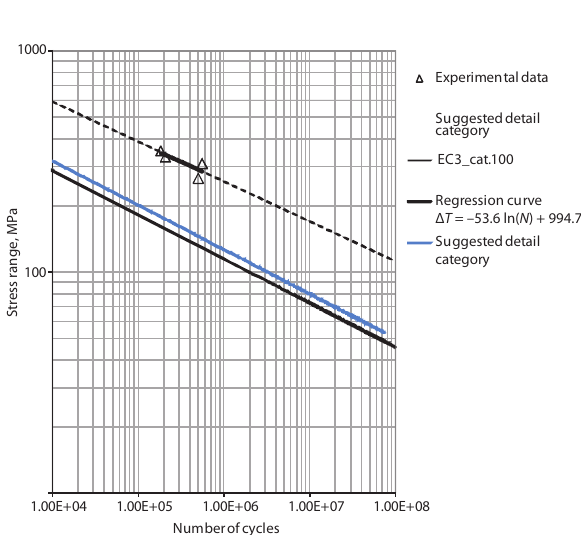
Fig. 4. Test data, best fit, suggested category C = 110 and fatigue design curve category 100 according EN 1993-1-9:2005 (Pipinato